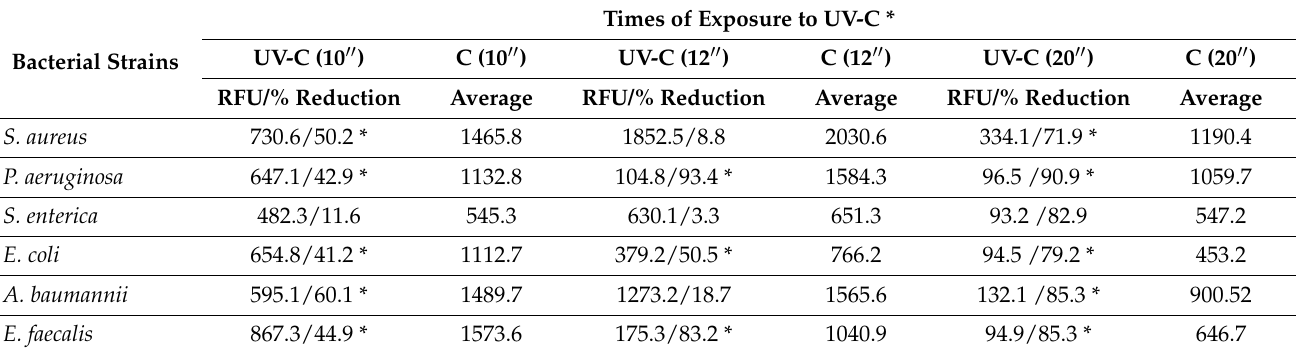
Table 1. Analysis of cell viability by the addition of resazurin after treatment with UV-C system (10, 12, and 20 s) and control group (no treatment) in different bacterial strains ATCCs (dilution 1:100) S. aureus (ATCC 6538), P. aeruginosa (ATCC 15442), S. enterica (ATCC 10708), E. coli (ATCC 25922), A. baumannii (ATCC 19606) and E. faecalis (ATCC 29212). Times of Exposure to UV-C *